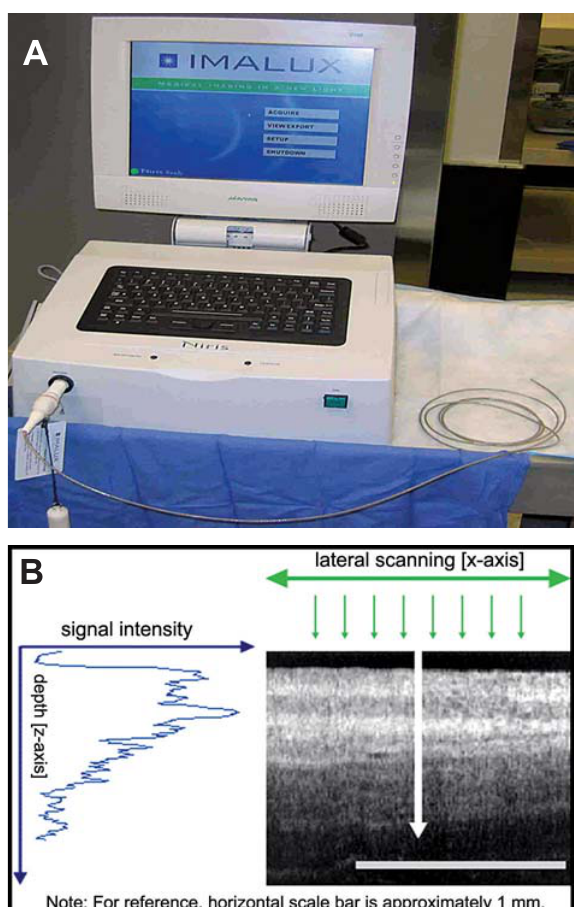
Figure 2 – A) Imalux Niris ™ Optical Coherence Tomogra- phy Imaging System. B) Illustration of 2D image